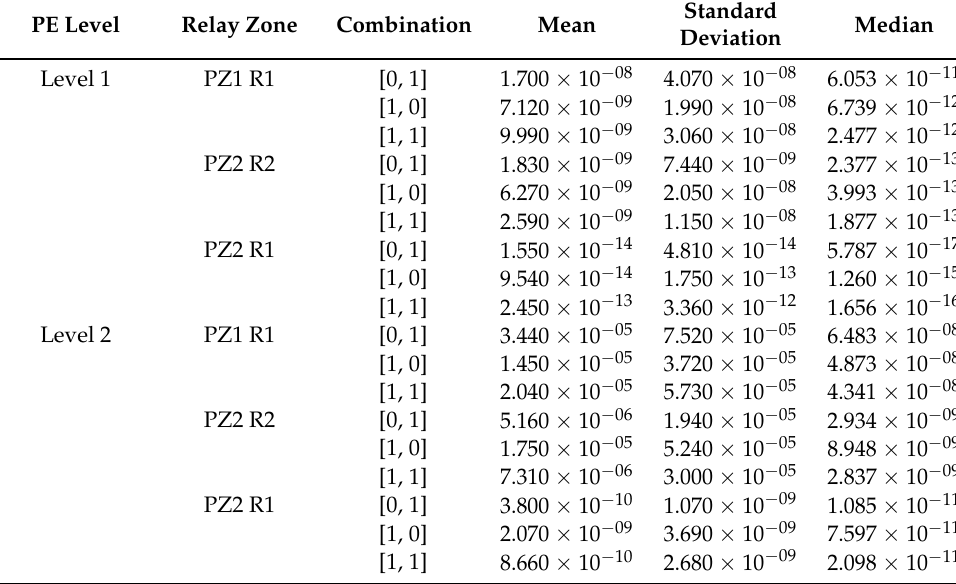
Table A4. PE values extra branch on protection